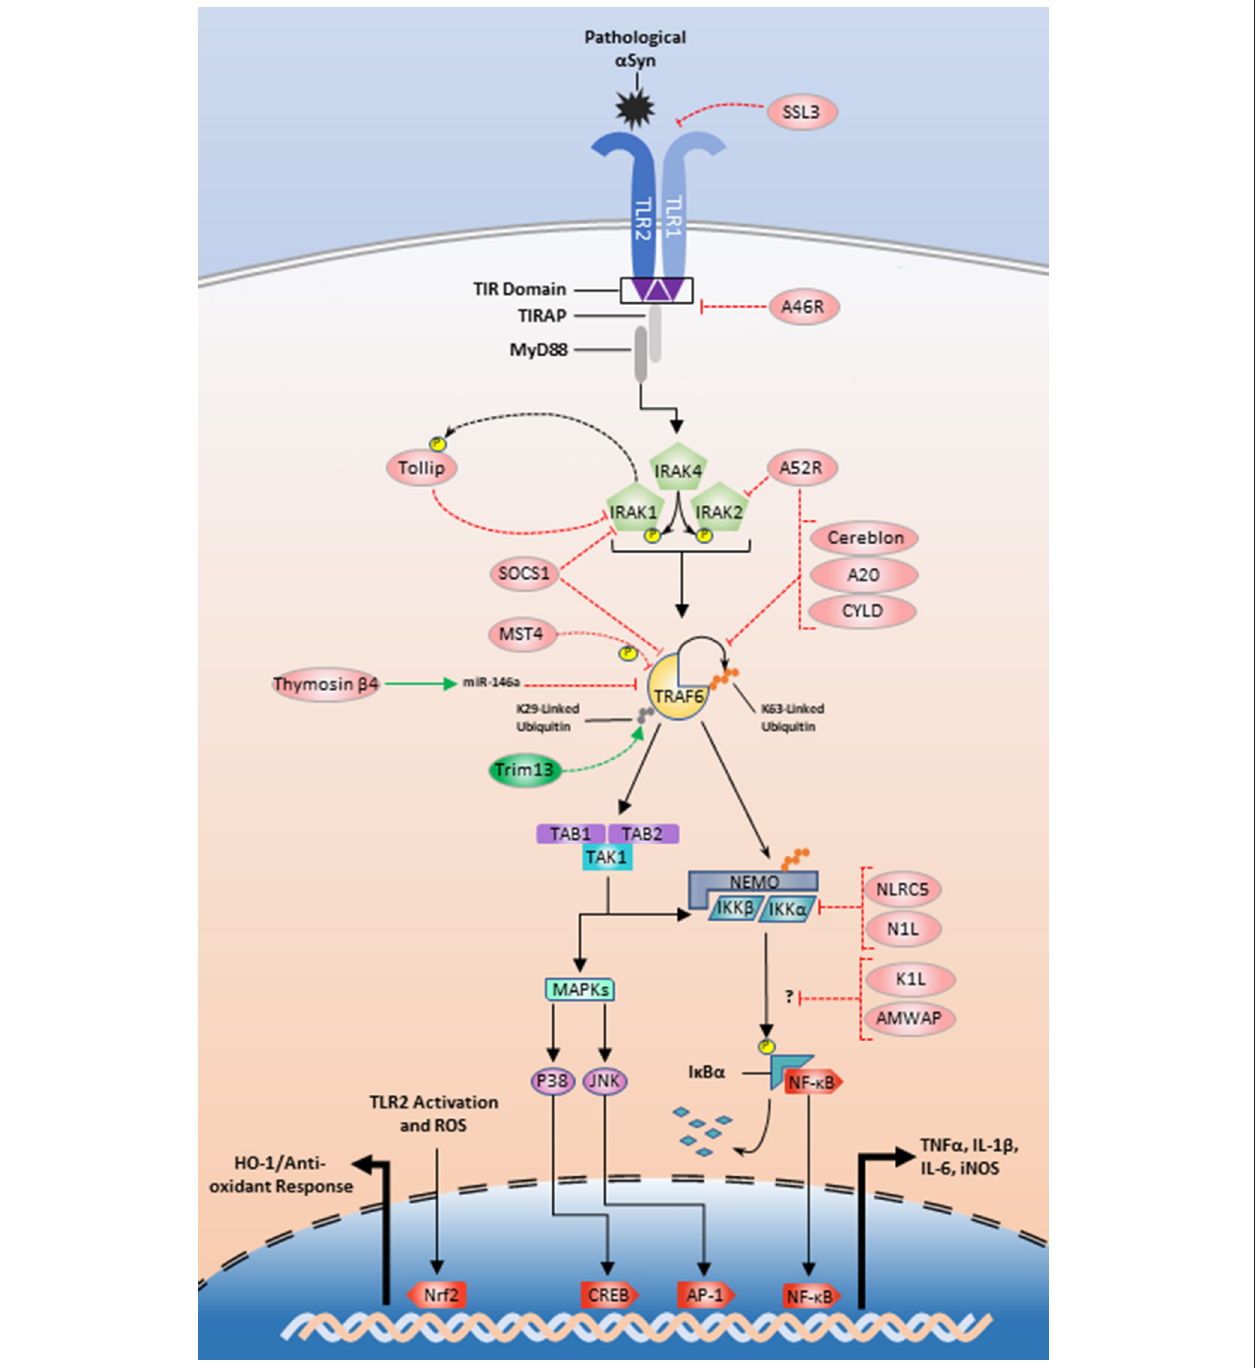
FIGURE 2 | Exogenous and endogenous protein regulation of the TLR2/1 signaling pathway. Initial regulation could begin with SSL3 inhibition of α Syn recognition or A46R disturbance of the MyD88-TIR interface (Node A; Figure 1 ). Tollip, A52 and SOCS1 could be manipulated to inhibit signaling at the IRAK complex (Node B; Figure 1 ). TRAF6 inhibition could be achieved by interference with Trim13 or positive modulation of SOCS1, MST4, thymosin β 4, cereblon, A52R, A20, and CYLD (Node C; Figure 1 ). Lastly NLRC5 and N1L could be positively upregulated to inhibit the IKKs (Node D; Figure 1 ). The modes of action for K1L and AMWAP are not established, but these two proteins along with upregulation of the transcription factor Nrf2 are also potential targets for TLR2/1 modulation.